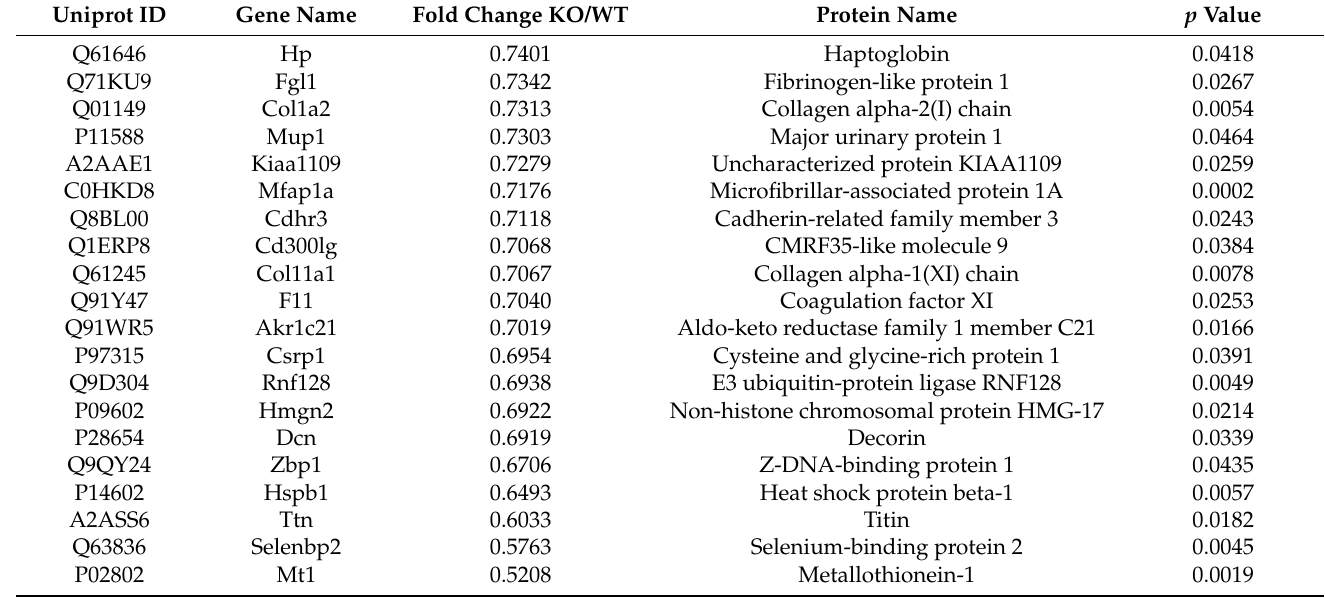
Table 2. Down-regulated hepatic DEPs in Selenot -KO mice (top